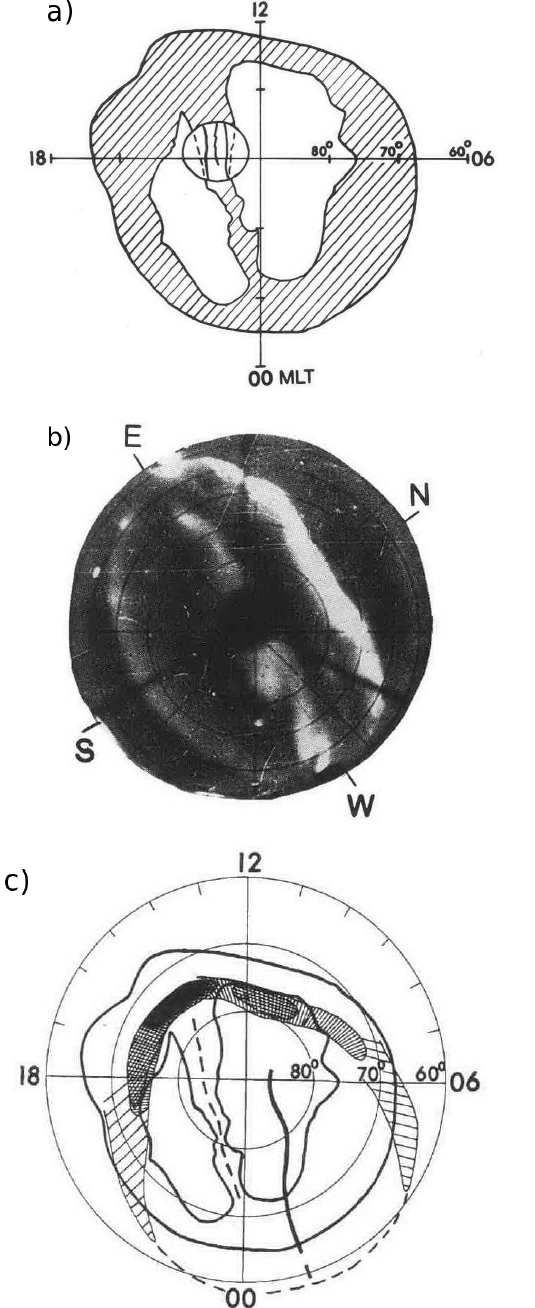
Figure 13. Distribution of the auroral luminosity over the Vos- tok observatory in the Southern Hemisphere ( 8 0 = − 83 . 3 ◦ , 3 0 = 53 . 8 ◦ ) on 3 August 1986, 18:24UT: (a) boundaries of UVI auroral luminosity in the Southern Hemisphere, the dashed area indicates the auroral luminosity, (b) the frame of all-sky camera film from the Vostok observatory, and (c) simultaneous aurora distributions in both hemispheres (different shadings indicate different auroral in- tensities) (Vorobjev et al.,